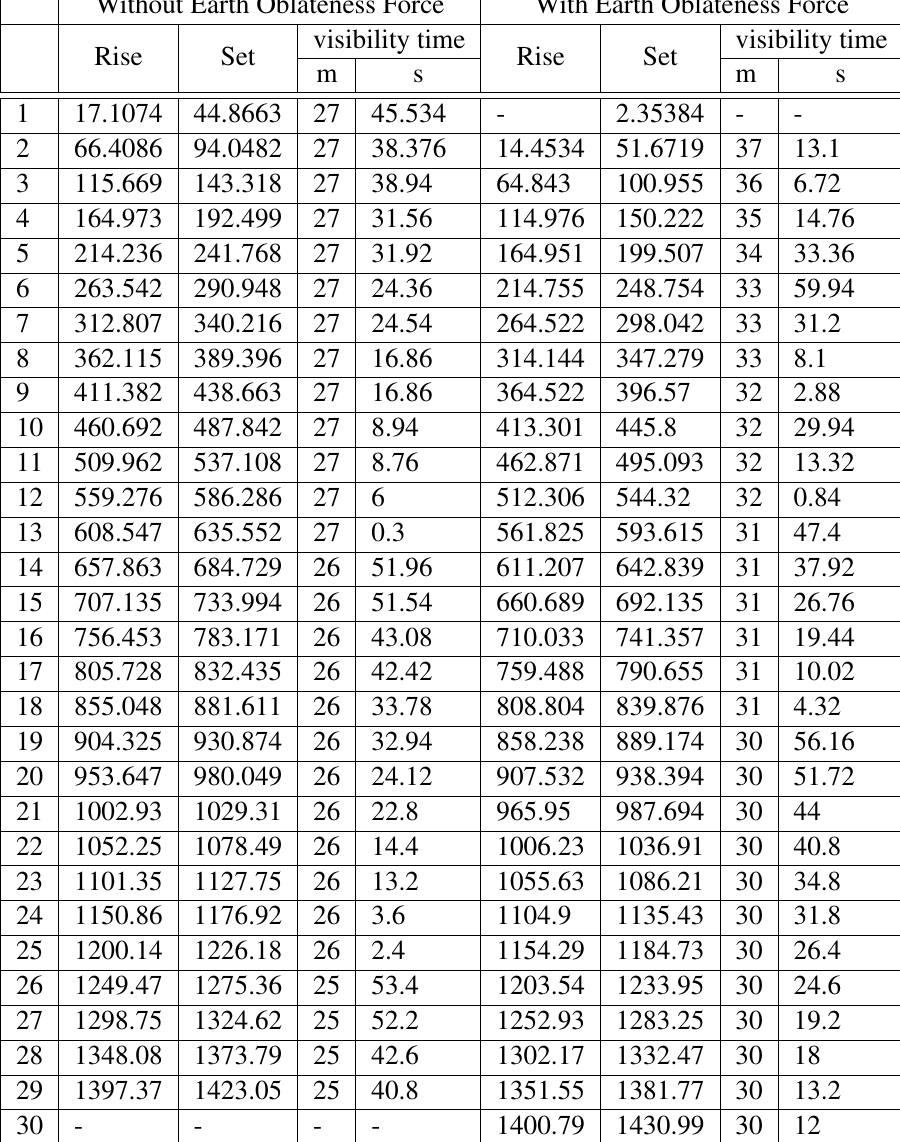
Table 3 Visibility Intervals Between AQUA and ARIRANG 24